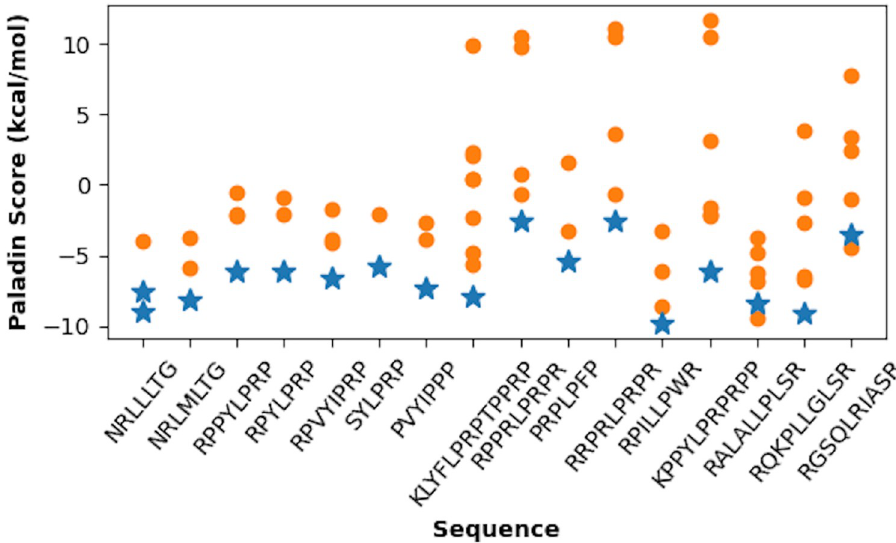
Fig 6. Registry predictions for forward-binding substrates. For each substrate, the Paladin scores are shown for all possible binding registries that allow all five sites on DnaK to be occupied. Both backbone orientations are considered (forward: blue; reverse: orange). The registries as observed in the PDB structures are shown with blue stars. Note that the NRLLLTG peptide has been crystallized in two registries (PDB: 1DKZ, 4EZW).